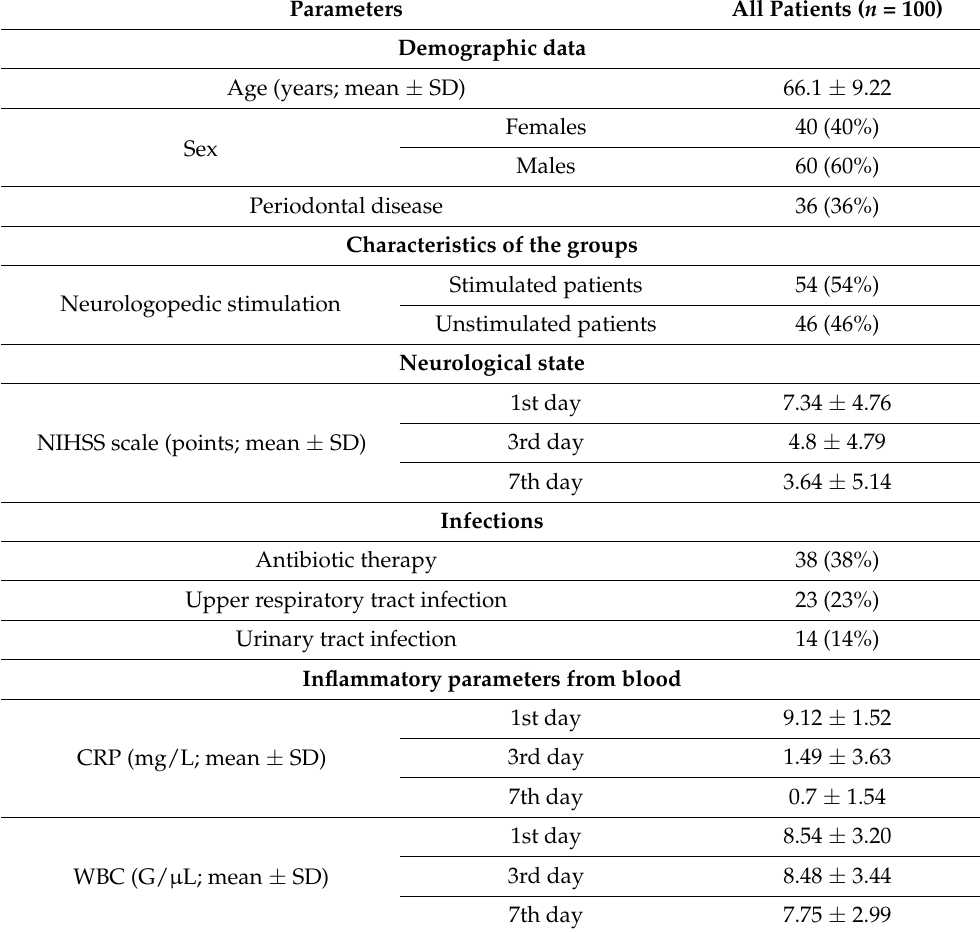
Table 1. General characteristics of the examined